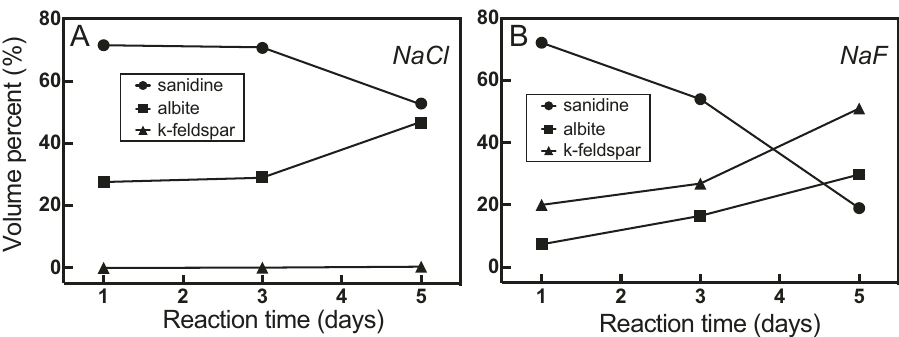
Fig. 1 Fraction of reactant and reaction products as function of time. A In NaCl solution. B In NaF solution. The analysis uncertainty is ±1%. No error bar is shown as the standard error falls within the size of the symbol. For details of the uncertainty, please check the Supplementary